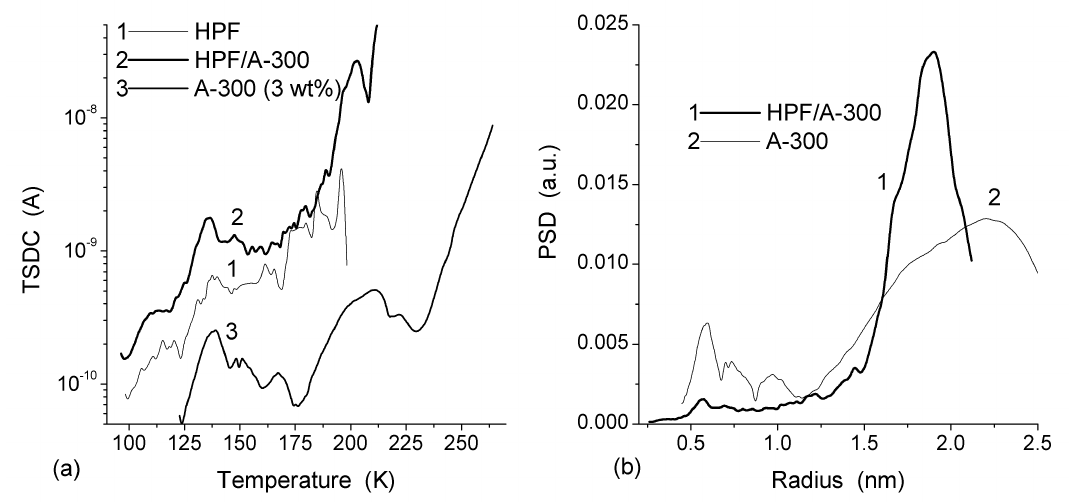
Fig. 9 (a) TSDC thermograms of fibrinogen (2.5 wt% HPF in aqueous solution with